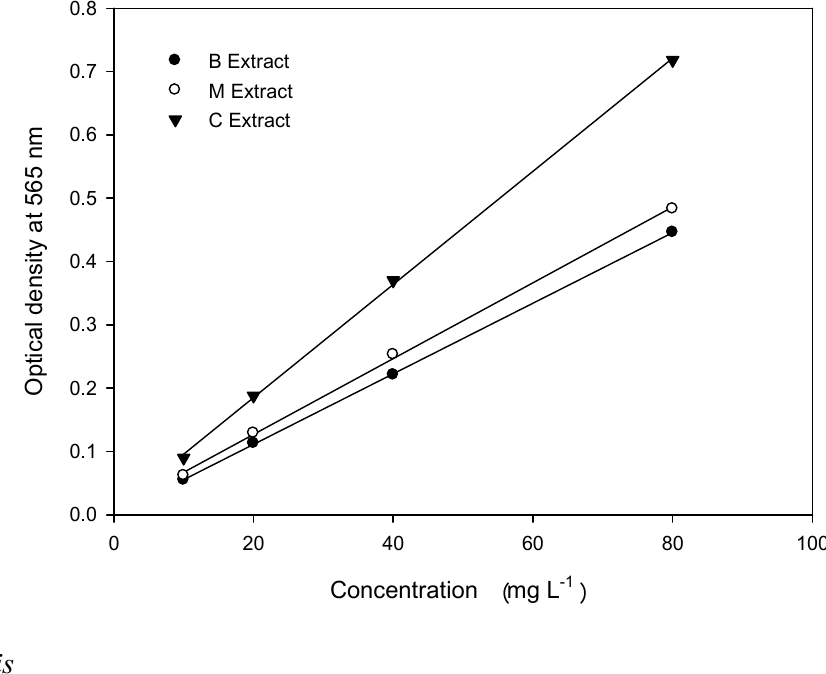
Figure 1. Relationship between the concentrations of B, M and C plant extracts and their corresponding optical densities at 565